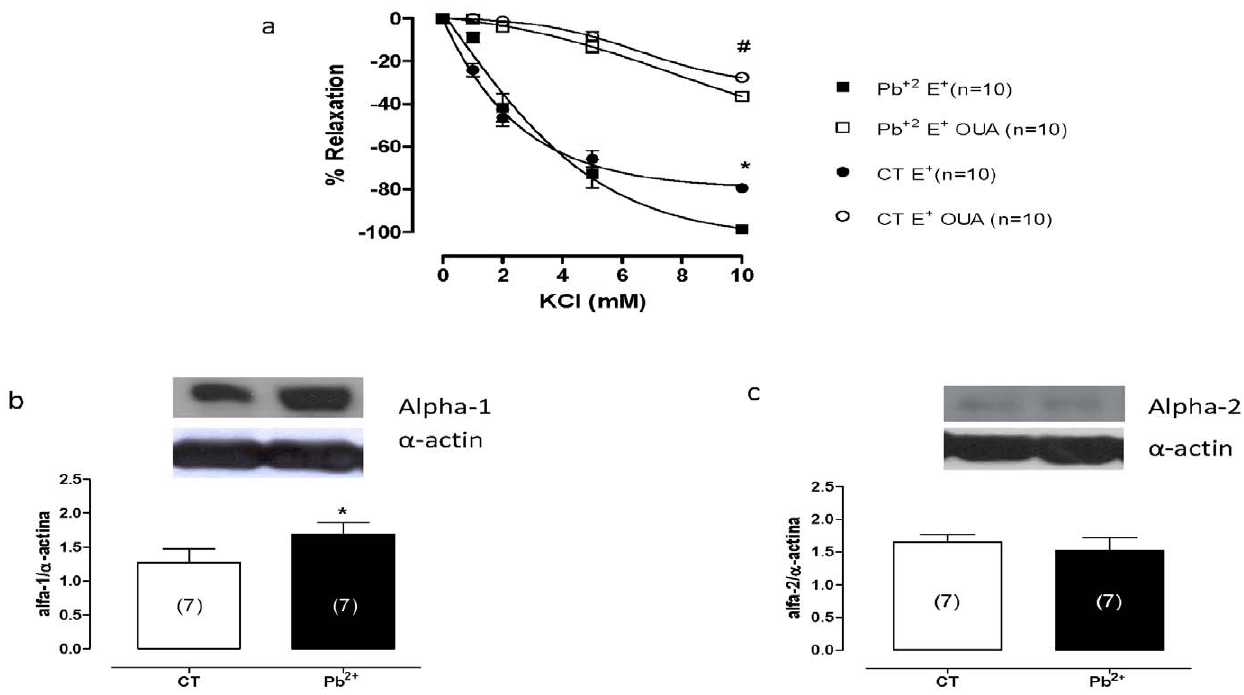
Figure 6. Potassium-induced relaxation in aortic rings from untreated (CT) and lead-treated (Pb + 2 ) rats previously incubated in a K + -free medium and contracted with phenylephrine before and after incubation with 100 m M ouabain (A). Densitometry analyses of the western blots for the alpha-1 subunit (B) and alpha-2 subunit (C) in aortas from untreated (CT) and lead-treated rats (Pb + 2 ). Representative blots are also shown. *P , 0.05 (CT vs. Pb + 2 ) by Student’s t- test or two-way ANOVA followed by a Bonferroni test. # P , 0.05 (CT OUA vs. Pb + 2 OUA) by two- way ANOVA followed by a Bonferroni test. Number of animals used is indicated in parentheses.